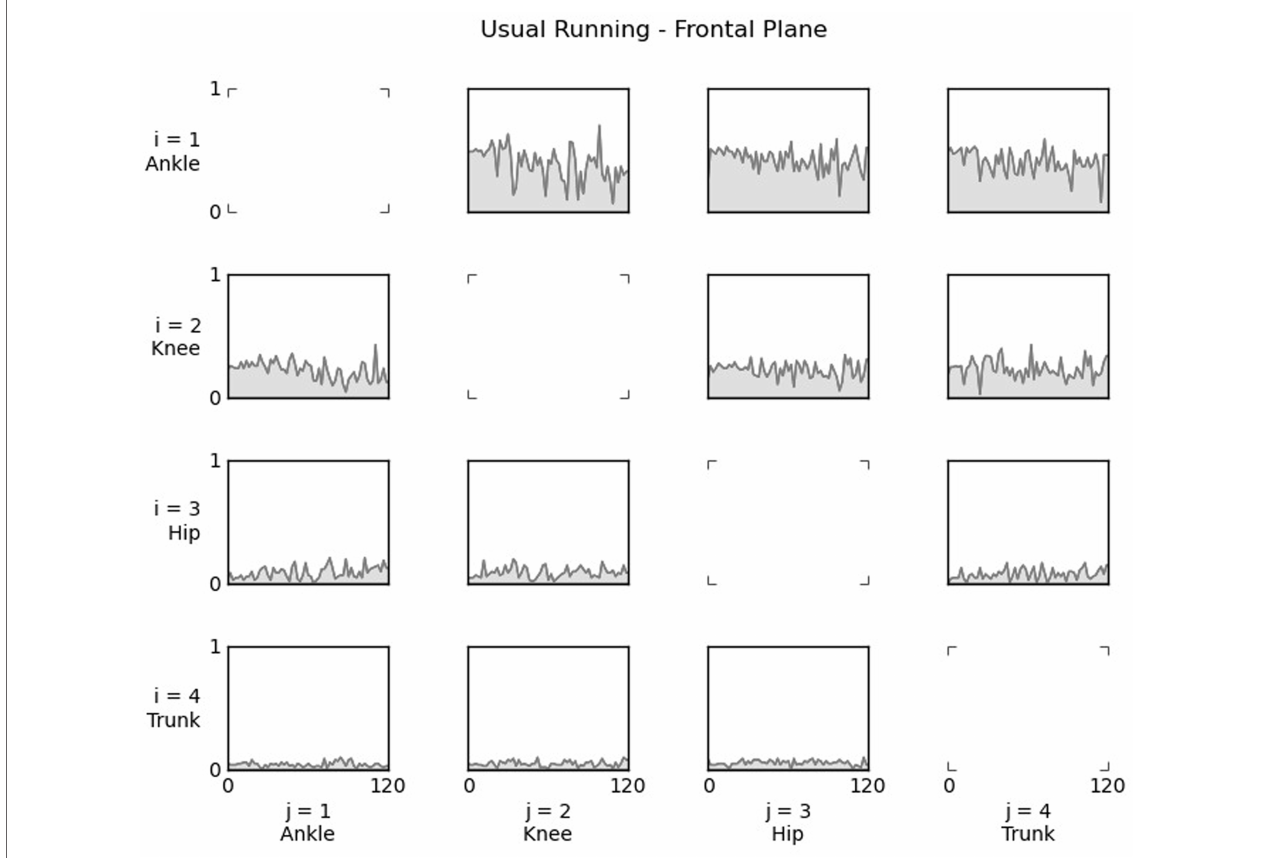
FIGURE 3 | PDC values computed from 3D kinematic data, in the sagittal plane, collected during usual running from one subject. For each cell, the influence is from j -channel to i -channel. Thus, in the second line, the first plot shows the influence from the ankle ( j = 1) to the knee ( i = 2).